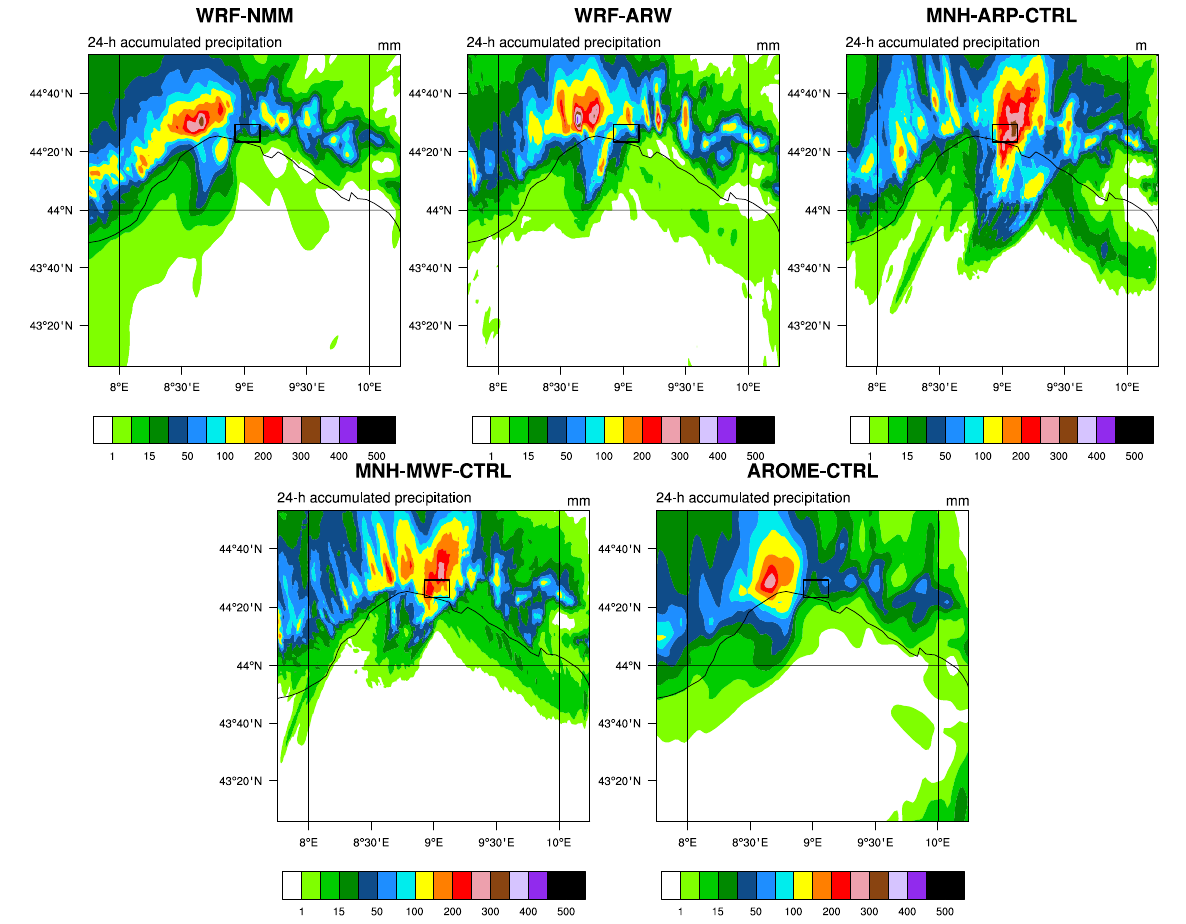
Figure 5. The 24h simulated rainfall amounts (in mm) of the WRF-NMM, WRF-ARW, MNH-ARP-CTRL, MNH-MWF-CTRL and AROME-CTRL simulations. Table 1. The characteristics of the different meteorological and hydrological ensembles performed for the case of 4 November